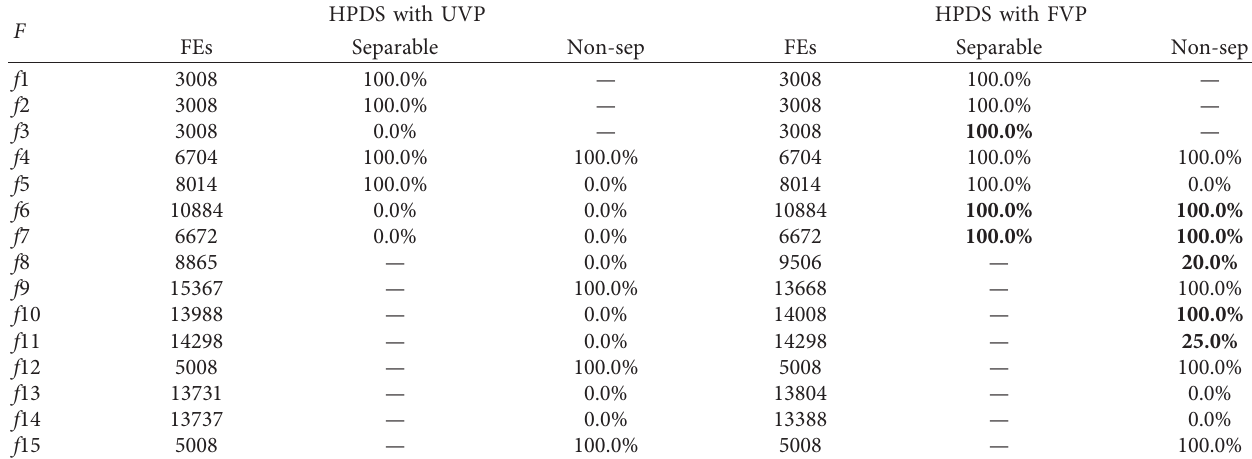
Table 3: Decomposition results of HPDG with UVP and FVP on 1000-dimensional CEC’2013 special sessions on large-scale global optimization. For each function, the best values of FEs and decomposition accuracy among different decomposition methods are shown in bold,